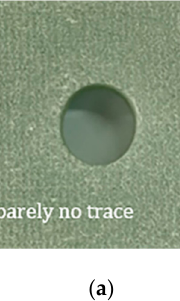
Figure 9. Plate surfaces of G60#-S24# connection after shear test. ( a ) GFRP connecting plate surface after shear test; ( b ) stainless-steel cover plate surface after shear test.